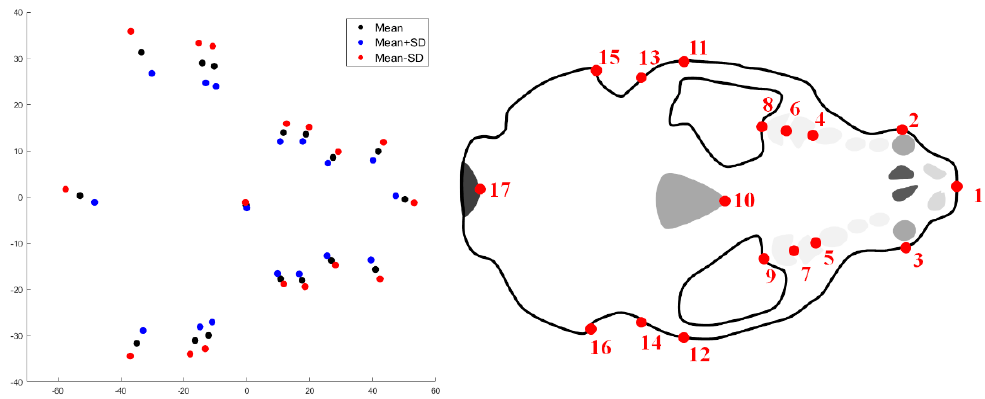
Figure 5. Sexual dimorphism in cranial size illustrated using mPCA (left-hand figure) for unscaled shape data for 17 points on the bottom of the crania (schematic shown again in the right-hand figure for the sake of comparison only). Blue dots represent females (mean + SD) red dots represent males (mean – SD). (Note that axes are measured in mm.).